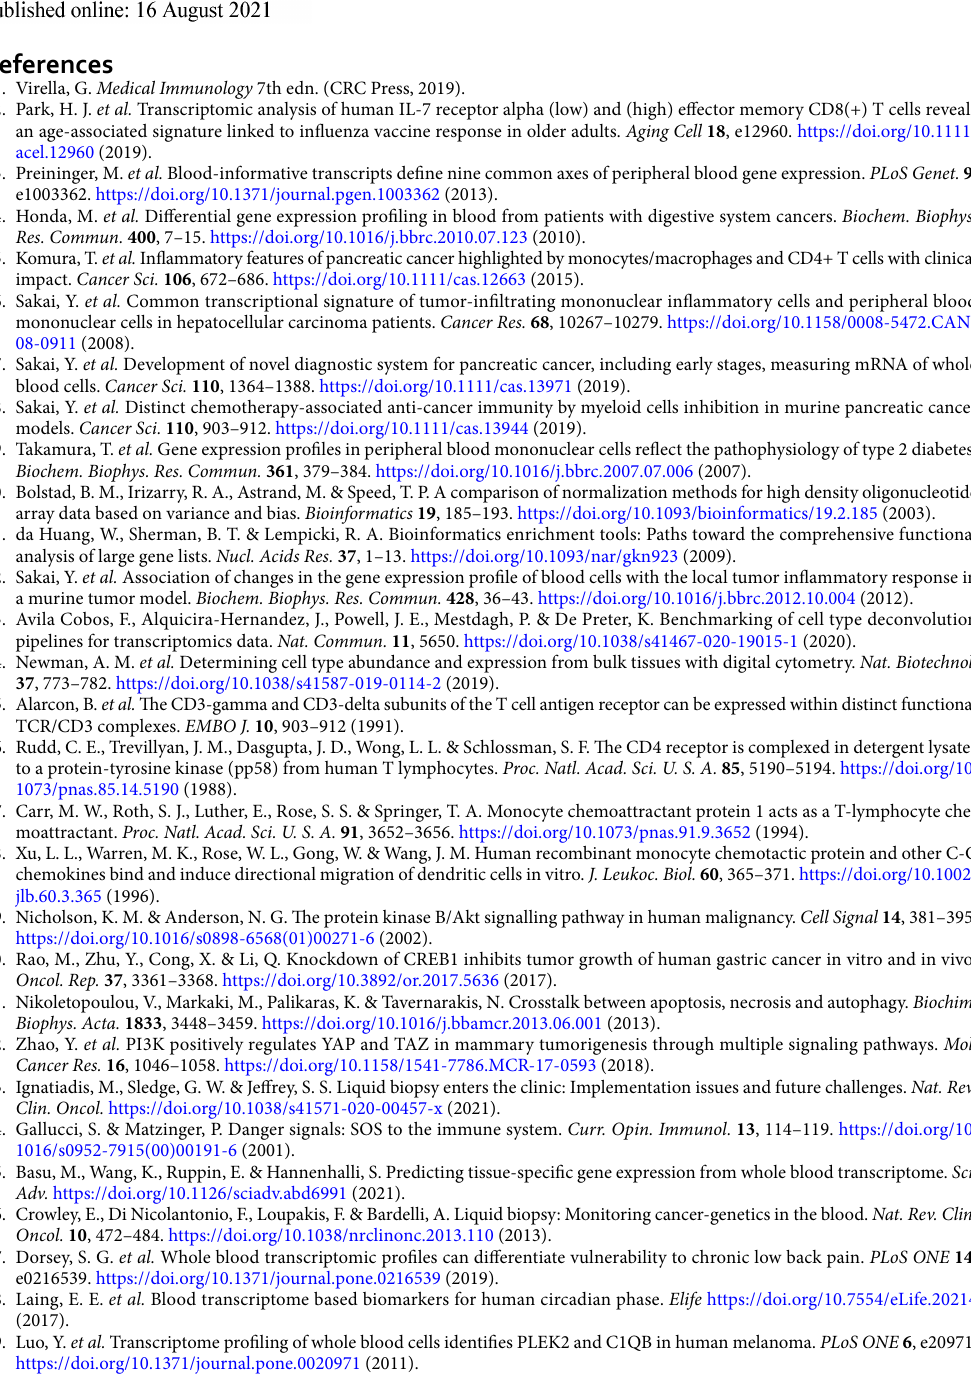
Figure 5. Deconvolution analysis for the estimation of cell types in blood and variability in cell frequency over time. We used 10,590 genes for deconvolution analysis/digital cytometry with the analytical tool CIBERSORTx. Cell frequencies were obtained by using 22 reference immune cell types. Out of the 22 immune cell types investigated, we obtained ( a ) 14 cell types whose frequency remained unaltered and ( b ) 8 cell types whose frequency changed over time; the summation of the frequencies of the 22 immune cells corresponds to the total frequency of 100%. ( a , b ) n = 61 for the years 2008, 2012, and 2016. Grey boxes indicate the interquartile range (25–75% percentile range), the median is indicated by a horizontal line within the box, and the mean is indicated by the small white square; whiskers represent ± 1 SD from the mean. The Kruskal–Wallis test and post hoc Conover test were performed as statistical analysis and are shown under each relative